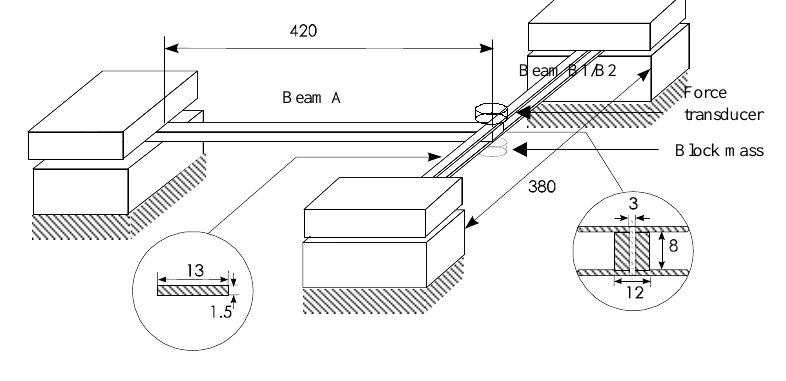
Fig. 1. Experimental setup.